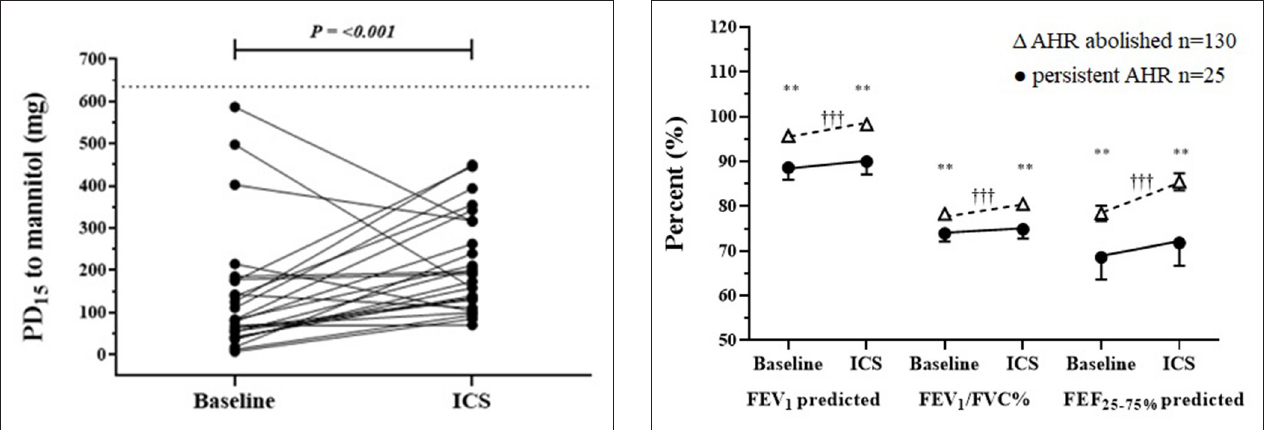
FIGURE 3 | Baseline and follow-up treatment spirometry results following a mean of 20 weeks daily ICS in those where AHR was either abolished or was persistent for FEV 1 and FEF 25 − 75 % % predicted, FEV 1 /FVC absolute % mean ± SD. † Within/*Between group differences at each visit. P -value: < 0.05* † , < 0.1** †† , < 0.001*** †††